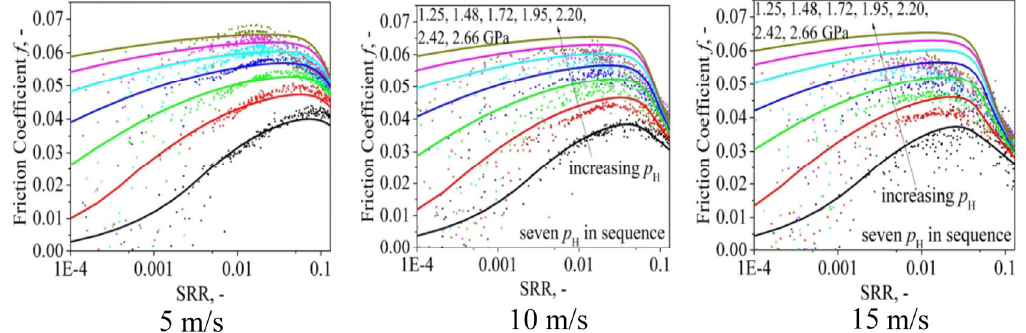
Fig. 52 Traction curve comparison between simplified traction calculation and twin-disc measurements [854]. Reproduced with permission from Ref. [854], © Elsevier Ltd.,